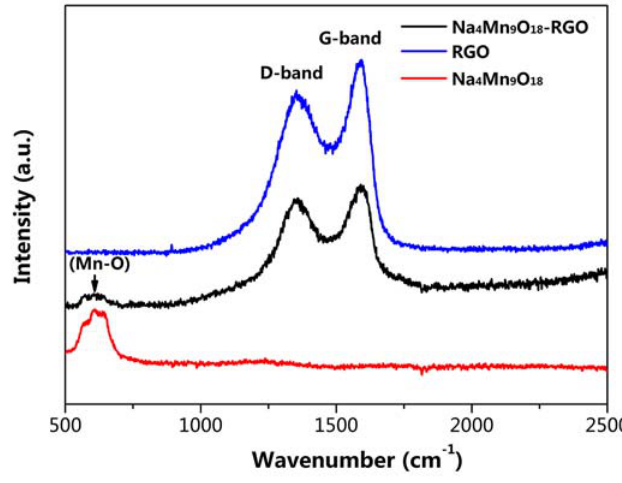
Figure 3. Raman spectrum of Na 4 Mn 9 O 18 , Na 4 Mn 9 O 18 -RGO, and RGO.